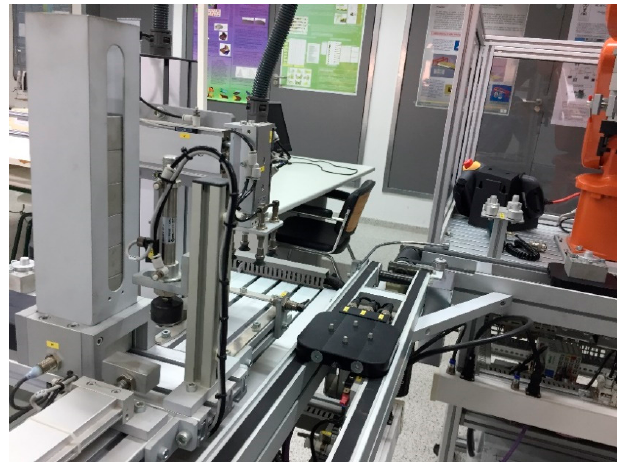
Figure 3. Station FMS-201: Body supply.